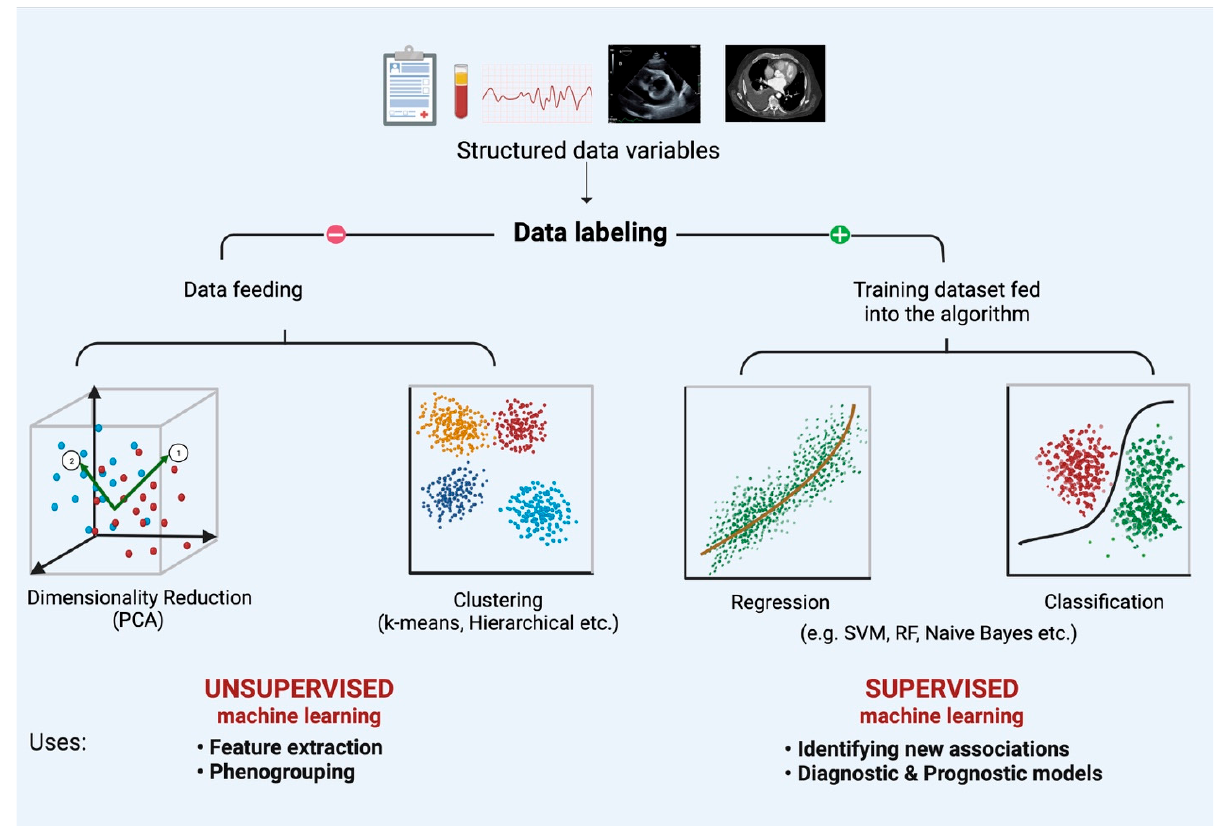
Figure 1. An overview of unsupervised and supervised machine learning. Labeled data can be processed in an unsupervised fashion (i.e., without training data) to understand relationships between variables, clustering, etc. Supervised machine learning, on the other hand, requires a training dataset, which can be used to either infer quantitative relationships (regression models) or classify data into training outcomes (classification). Abbreviations: SVM: Support Vector machines; RF: Random Forest. Adapted from Gautam et al. [13].